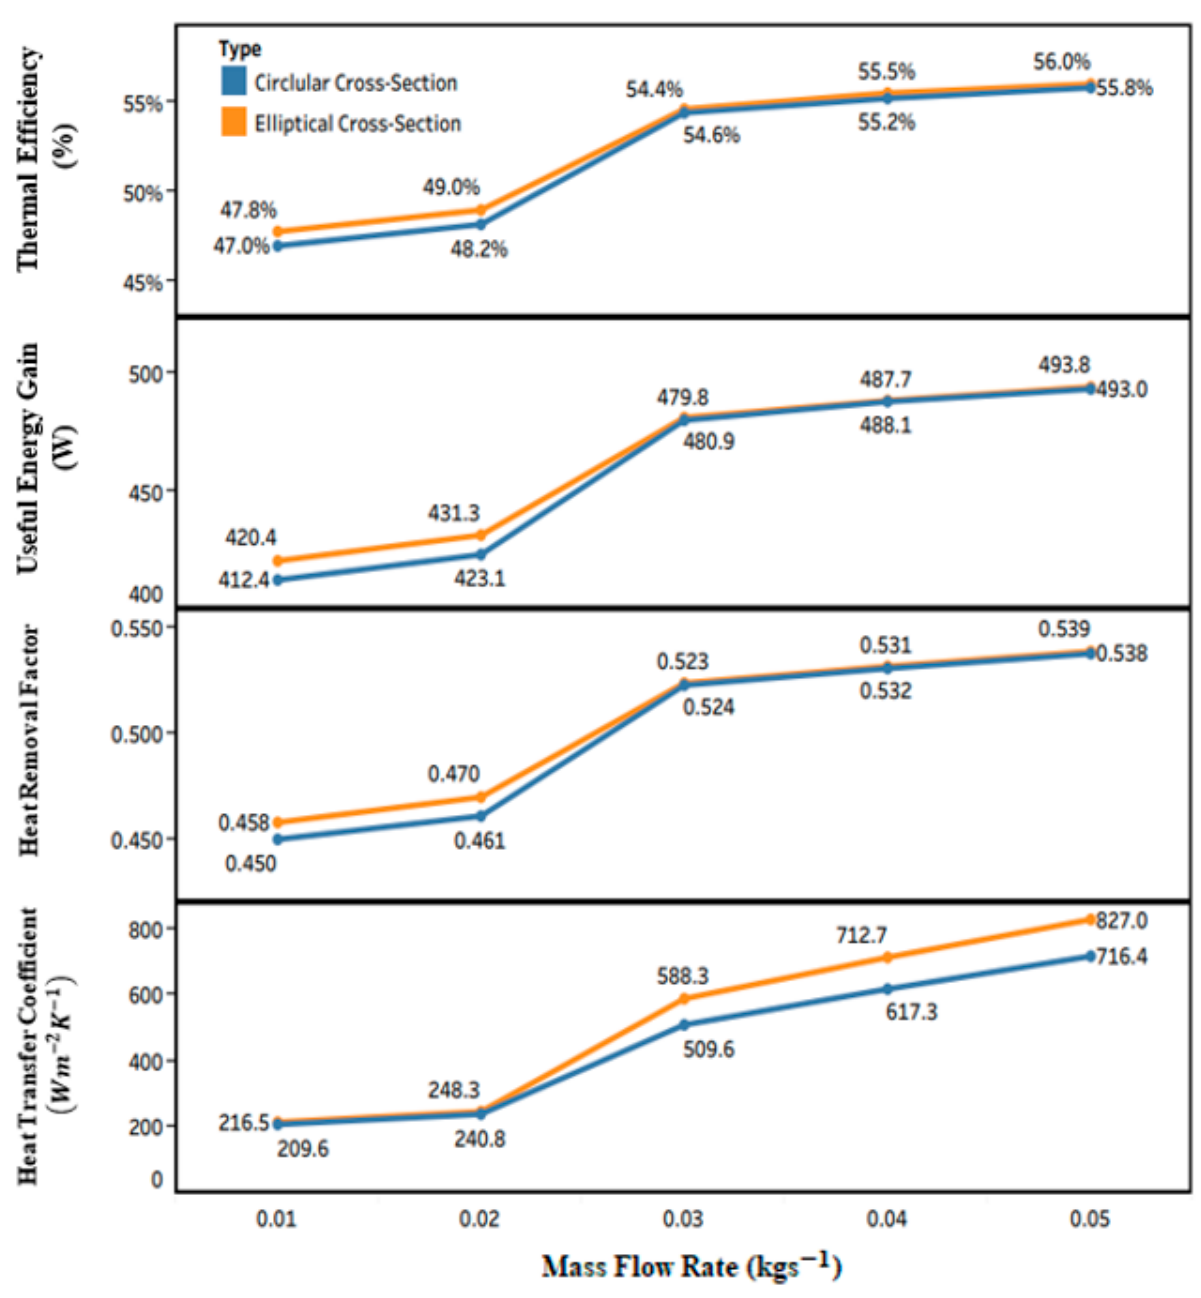
. m on h fi , F R , Q u , and µ Th